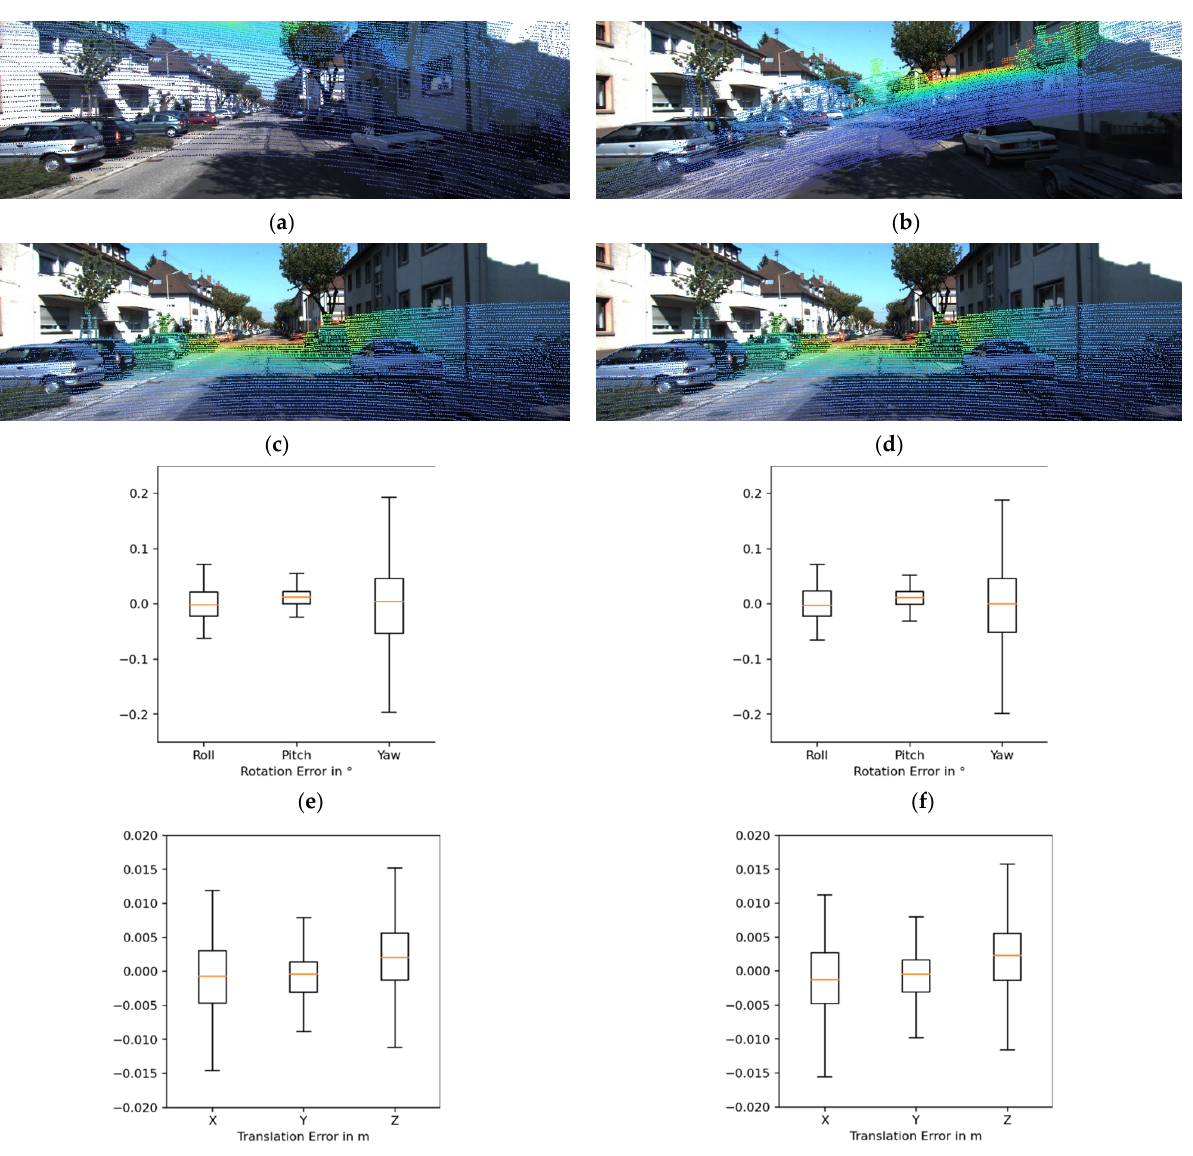
Figure 4. Calibration results and error distribution when temporal filtering was applied. ( a ) Trans- formation by randomly sampled deviation from Rg1. ( b ) Transformation by randomly sampled deviation from Rg1. ( c ) Calibration results from random deviations shown in ( a ). ( d ) Calibration results from random deviations shown in ( b ). ( e ) Rotation error for the results shown in ( c ). ( f ) Rotation error for the results shown in ( d ). ( g ) Translation error for the results shown in ( c ). ( h ) Translation error for the results shown in ( d ).